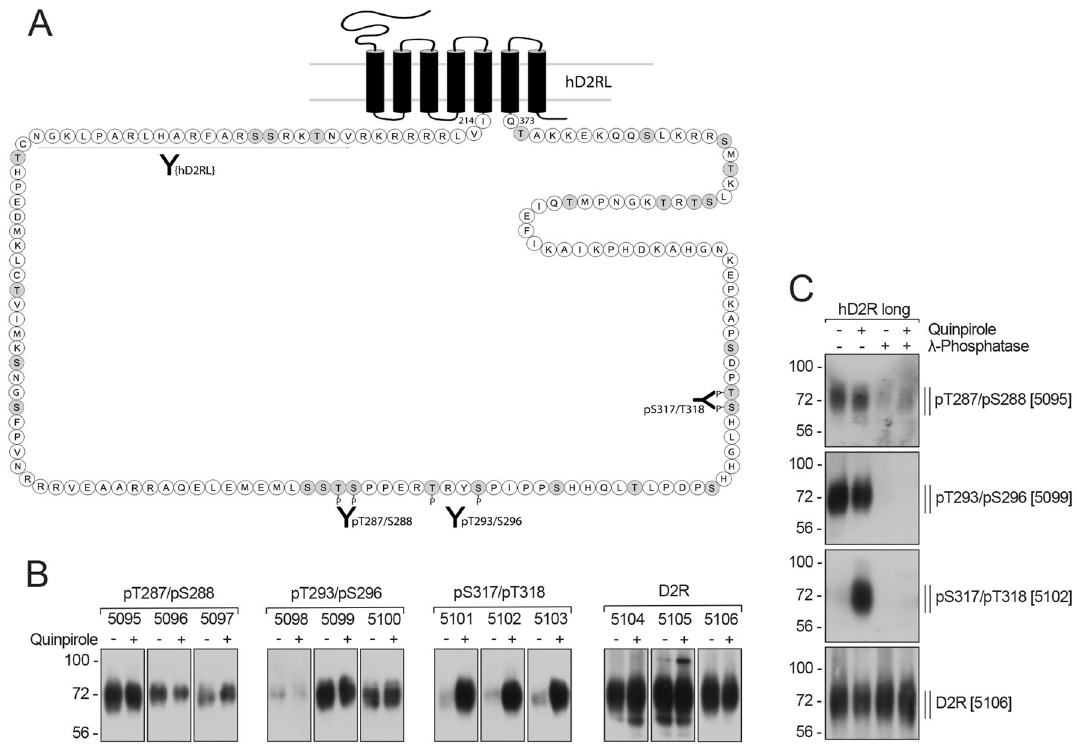
Figure 1. Characterization of phosphosite-specific D 2 R antibodies. ( A ) Schematic representation of the long splice variant of the human dopamine D 2 receptor (hD 2L R). All potential phosphate acceptor sites in the third intracellular loop are indicated (gray). Thr 287 /Ser 288 , Thr 293 /Ser 296 and Ser 317 /Thr 318 were targeted for the generation of phosphosite-specific antibodies and the epitope used for generating a phosphorylation- independent antibody (D2RL) is indicated by a black line. This figure was generated using Adobe InDesign CS6. ( B ) HEK293 cells stably expressing HA-tagged D 2 R were either untreated (−) or treated ( +) with 1 µM quinpirole for 10 min at 37 °C. Cells were lysed and immunoblotted with the anti-pThr 287 /Ser 288 (5095–5097), anti-pThr 293 /Ser 296 (5098–5100), anti-pSer 317 /Thr 318 (5101–5103) or anti-D 2 R antibodies (5104–5106), respectively. Blots are representative, n = 3. ( C ) Characterization of phosphosite-specific antibodies directed against Thr 287 /Ser 288 , Thr 293 /Ser 296 and Ser 317 /Thr 318 using λ-phosphatase. Cells described in ( B ) were either untreated (−) or treated ( +) with 1 µM quinpirole for 10 min at 37 °C. Lysates were then either incubated ( +) or not (−) with λ-phosphatase and immunoblotted with the phosphosite-specific antibodies to pThr 287 / Ser 288 [5095], pThr 293 /Ser 296 [5099], or pSer 317 /Thr 318 [5102]. Blots were stripped and re-probed with the phosphorylation-independent antibody to D 2 R [5106] as a loading control. Blots are representative, n = 3. Molecular mass markers (kDa) are indicated,